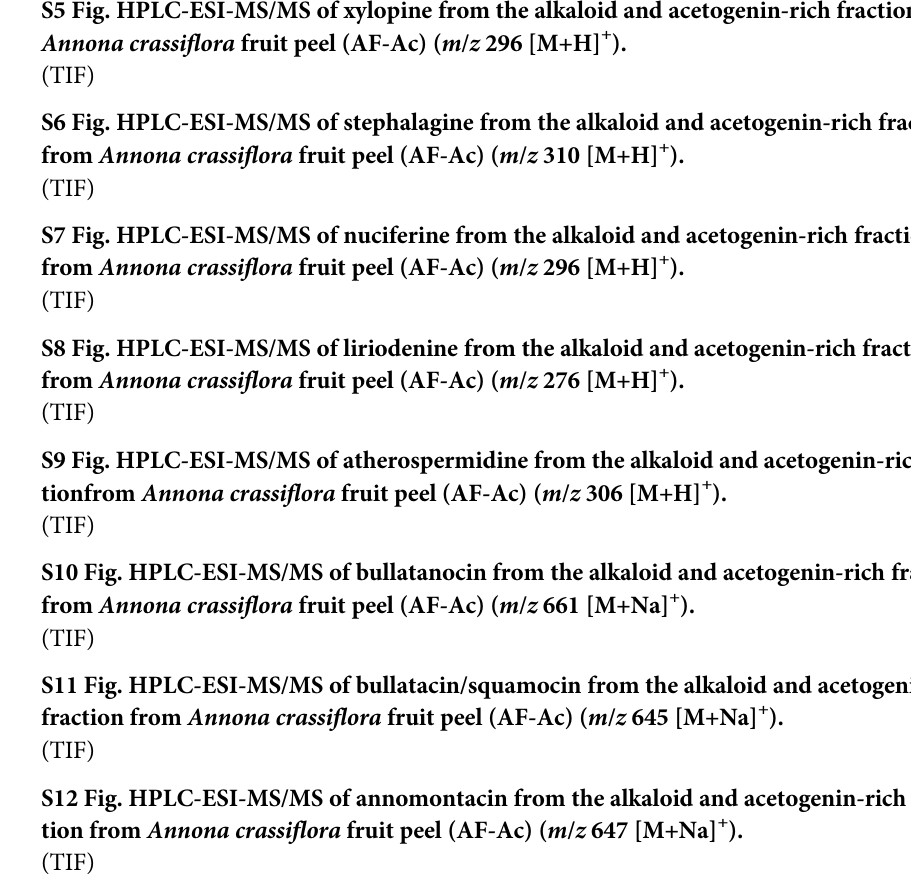
S5 Fig. HPLC-ESI-MS/MS of xylopine from the alkaloid and acetogenin-rich fraction from Annona crassiflora fruit peel (AF-Ac) ( m / z 296 [M+H] + ). (TIF) S6 Fig. HPLC-ESI-MS/MS of stephalagine from the alkaloid and acetogenin-rich fraction from Annona crassiflora fruit peel (AF-Ac) ( m / z 310 [M+H] + ). (TIF) S7 Fig. HPLC-ESI-MS/MS of nuciferine from the alkaloid and acetogenin-rich fraction from Annona crassiflora fruit peel (AF-Ac) ( m / z 296 [M+H] + ). (TIF) S8 Fig. HPLC-ESI-MS/MS of liriodenine from the alkaloid and acetogenin-rich fraction from Annona crassiflora fruit peel (AF-Ac) ( m / z 276 [M+H] + ). (TIF) S9 Fig. HPLC-ESI-MS/MS of atherospermidine from the alkaloid and acetogenin-rich frac- tionfrom Annona crassiflora fruit peel (AF-Ac) ( m / z 306 [M+H] + ). (TIF) S10 Fig. HPLC-ESI-MS/MS of bullatanocin from the alkaloid and acetogenin-rich fraction from Annona crassiflora fruit peel (AF-Ac) ( m / z 661 [M+Na] + ). (TIF) S11 Fig. HPLC-ESI-MS/MS of bullatacin/squamocin from the alkaloid and acetogenin-rich fraction from Annona crassiflora fruit peel (AF-Ac) ( m / z 645 [M+Na] + ). (TIF) S12 Fig. HPLC-ESI-MS/MS of annomontacin from the alkaloid and acetogenin-rich frac- tion from Annona crassiflora fruit peel (AF-Ac) ( m / z 647 [M+Na] + ). (TIF) S13 Fig. HPLC-ESI-MS/MS of desacetyluvaricin/isodesacetyluvaricin from the alkaloid and acetogenin-rich fraction from Annona crassiflora fruit peel (AF-Ac) ( m / z 629 [M +Na] + ). (TIF) S14 Fig. Cell viability of fibroblasts cells treated with the alkaloid and acetogenin-rich frac- tions of Annona crassiflora fruit peel (AF-Ac) or vehicle (control, cells treated with RPMI- 1640 medium containing 0.05% DMSO). Results (mean ± SD, n = 3) expressed as the per- centage of viable cells compared to the vehicle group. Significance levels are indicated by � p < 0.05 and ��� p < 0.001 when compared to control (one-way ANOVA and Dunnett as posttest). The fibroblast cells (NIH/3T3) were grown in RPMI-1640 medium supplemented with fetal bovine serum 10% (FBS), 2 mM glutamine, 100 U/mL penicillin and 100 mg/mL streptomycin, at 37˚C and CO 5%. 3 x 10 4 cells were plated in 96-well plates and treated with 2 different concentrations of the AF-Ac fraction or vehicle and incubated for 24 h at 37˚C and 5% CO . Then, 100 μ L of 5 mg/mL (3-(4,5-dimethylthiazolyl-2) − 2,5-diphenyltetrazolium bro- 2 mide) solution was incubated with the supernatant at 37˚C for 2 h in 5% CO . Next, dimethyl 2 sulfoxide (DMSO) was added and the cell viability was analyzed by absorbance of the purple formazan from viable cells at 570 nm (Molecular Devices, Menlo Park, CA, USA). (TIF) S15 Fig. Time-lapse of HepG2 cells labeled with dihydroethidium (DHE) and exposed to the AF-Ac fraction (A). Quantification of the ROS production during 9 minutes after